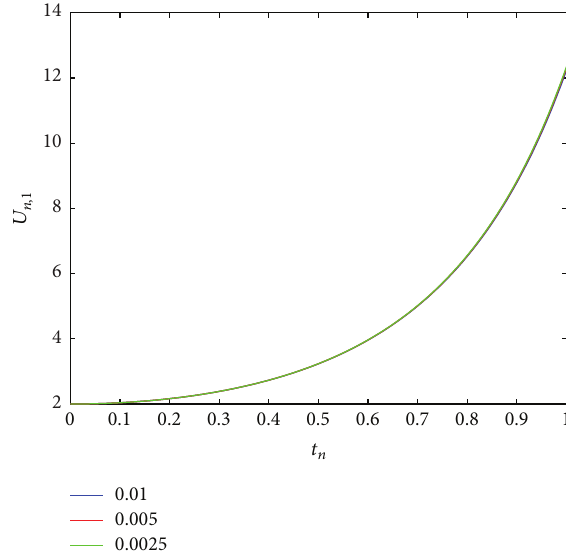
Figure 3: The iterated collocation solution of (48) when 𝑐 1 = 1/2 .